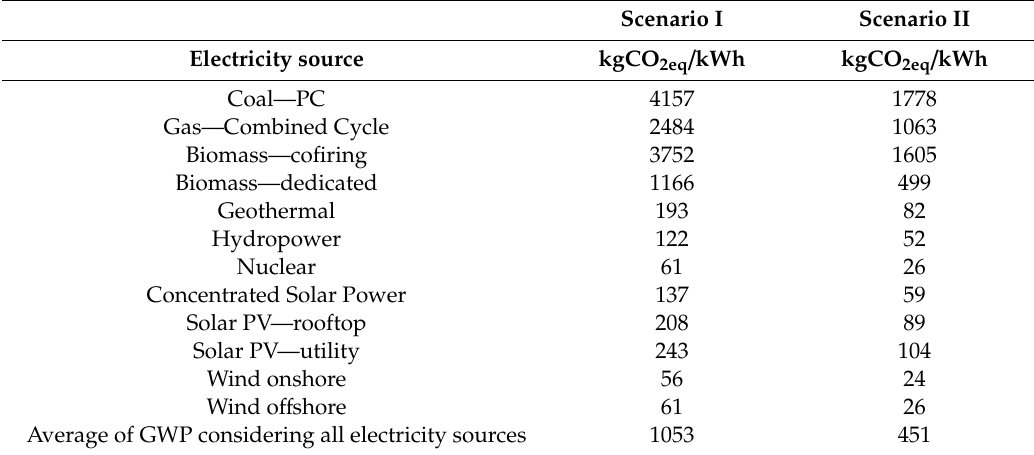
Figure 9. ( a ) Global Warming Potential (GWP) emissions in kgCO 2eq /t of whole stillage processed for the conventional system (Scenario I) and flocculation system (Scenario II) using di ff erent electricity supply technologies. ( b ) Ratio of the GWP emissions in kgCO2eq / t of whole stillage processed for the conventional system (Scenario I) and flocculation system (Scenario II) using di ff erent electricity supply technologies. Table 5. Emissions from a variety of electricity supply technologies for the conventional system (Scenario I) and flocculation system (Scenario